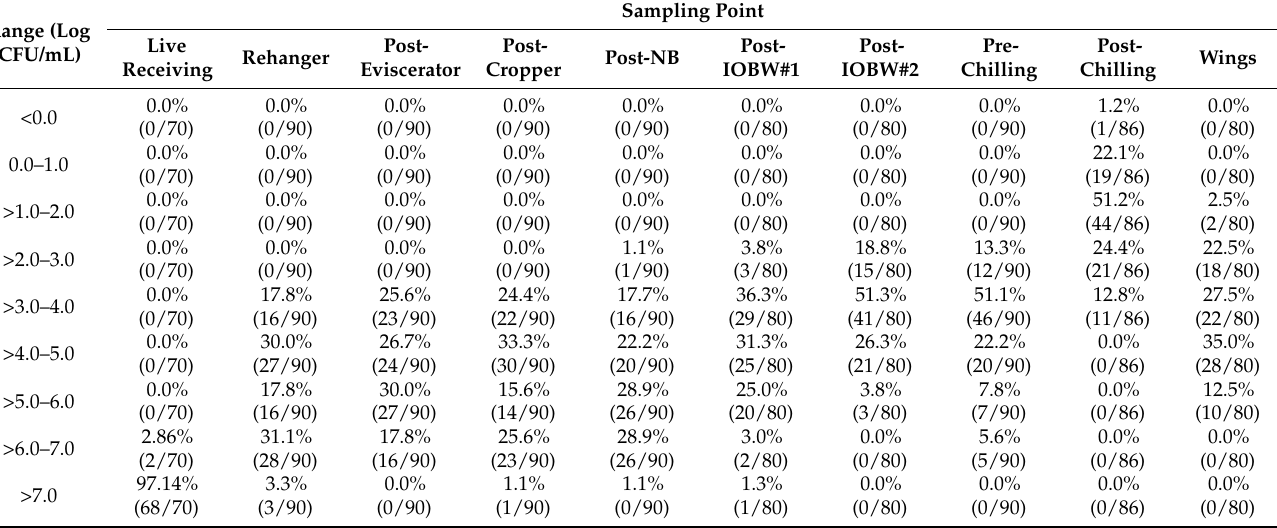
Table A4. Distribution of aerobic counts (Log CFU/mL) on each of the ten sampling locations under reduced process intervention on chicken and part rinses (n = 846